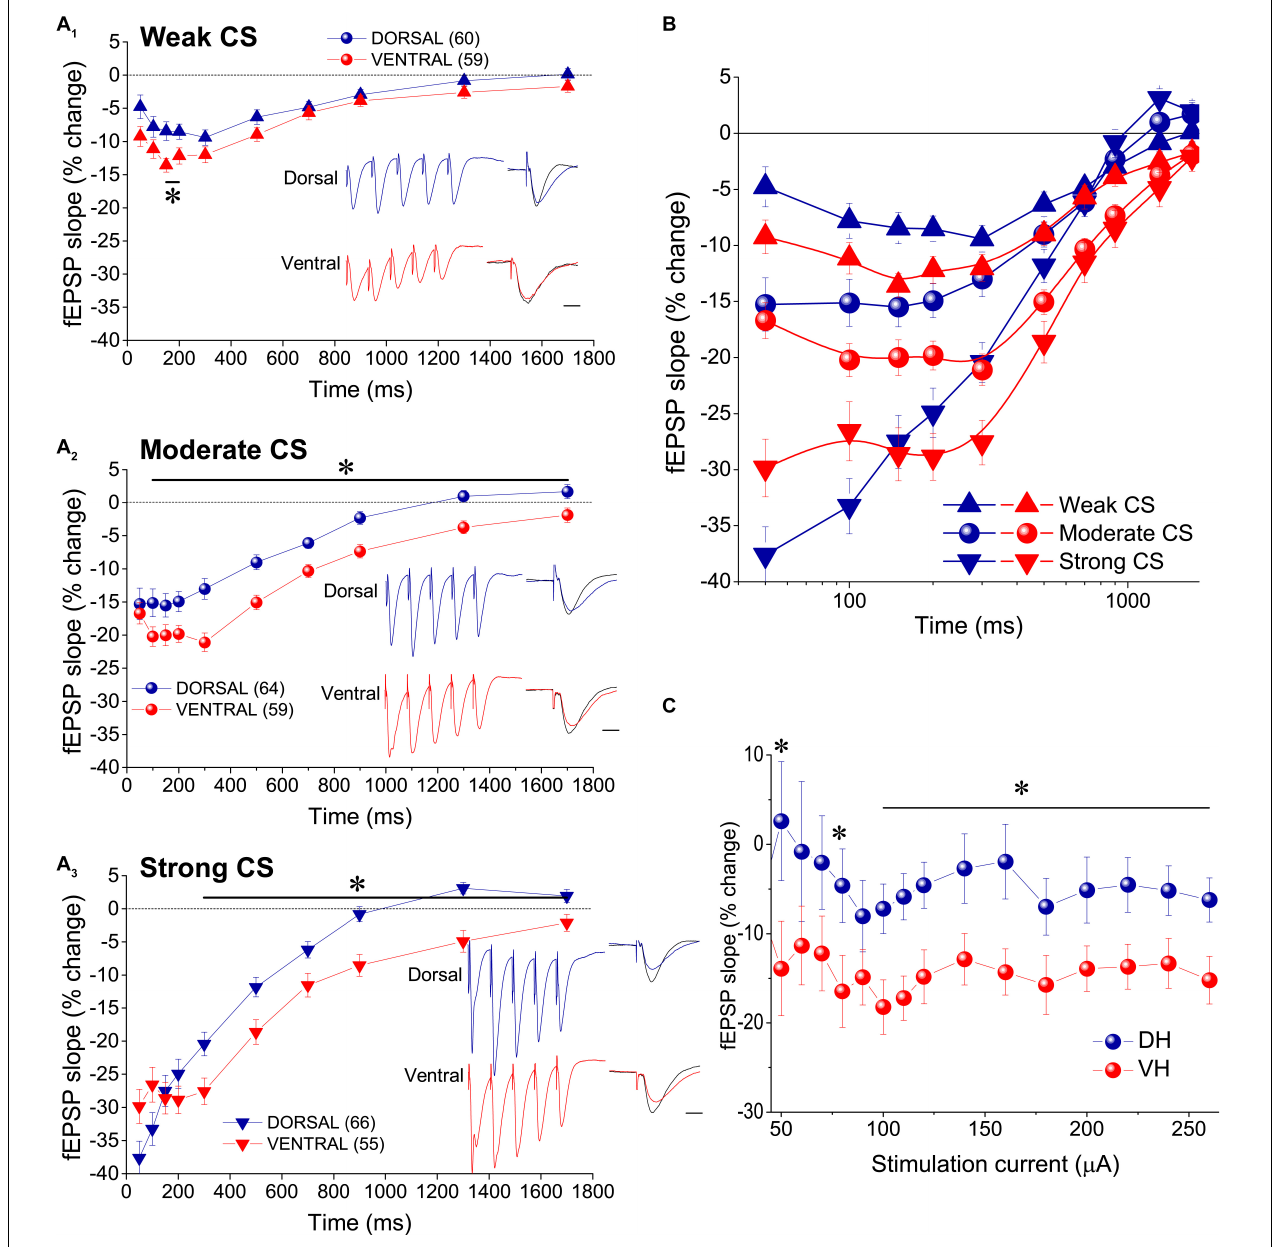
FIGURE 2 | tHSD is stronger and longer in the ventral compared with the dorsal hippocampus. (A) Diagrams presenting the time course of tHSD induced in the dorsal and the ventral hippocampus by weak (A 1 ) , moderate (A 2 ) , or strong (A 3 ) intensity of CS. Horizontal bars with an asterisk indicate the interval of statistically significant differences in tHSD between the dorsal and the ventral hippocampus, at p < 0.05 (paired t -test). Insert graphs represent example fEPSP trace recordings; a 150 ms-long interval between conditioning and test response is omitted for clarity. Traces in black denote control responses at the conditioned path. Calibration bars: 1 mV, 10 ms. Artifacts are truncated. (B) Time courses of tHSD induced by the three intensities of CS are shown for the dorsal and the ventral hippocampus for comparison. (C) Dorsal-ventral difference in tHSD produced by a CS of moderate intensity on a test response evoked by a stimulation intensity of variable size. The inter-stimulation interval was set at 300